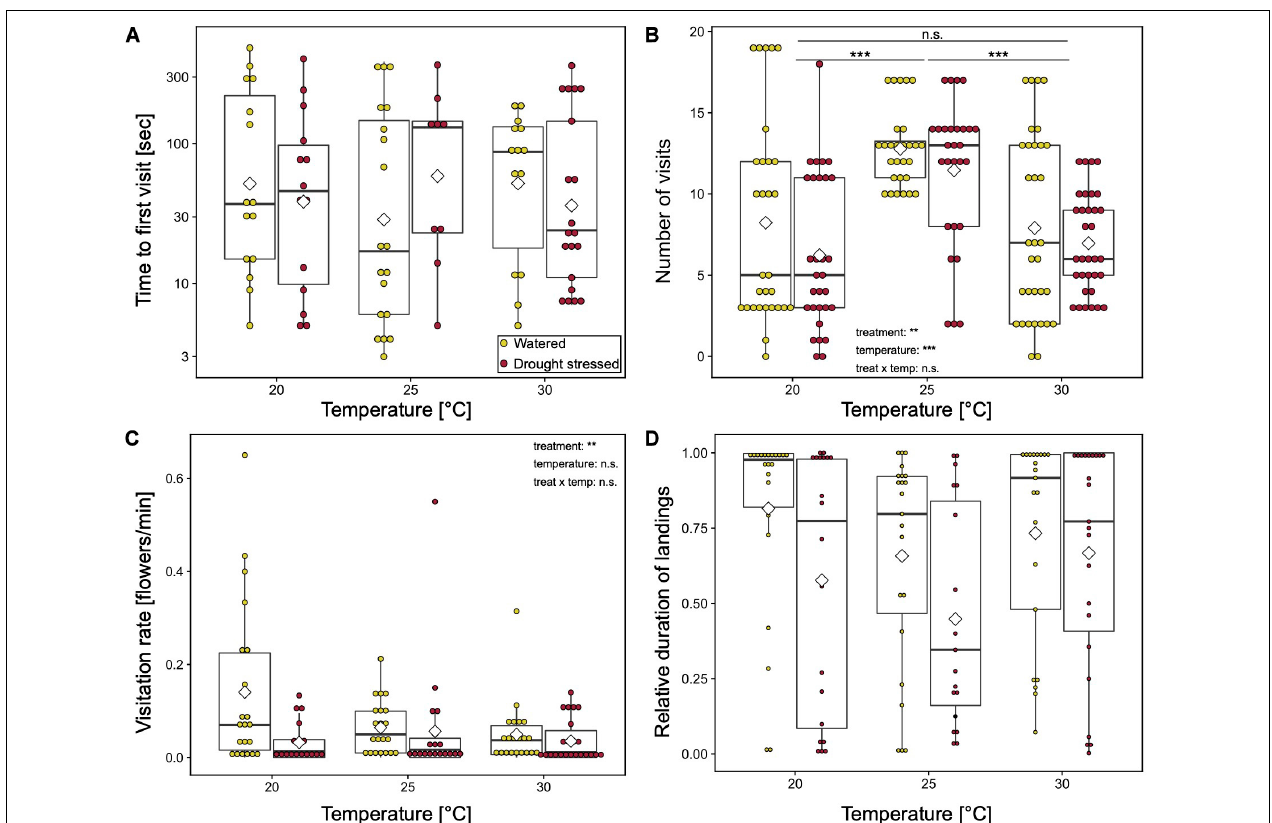
FIGURE 1 | Behavior of bumblebees at various temperatures with respect to watered and drought-stressed plants. (A) Time to first plant visit [sec] (approach or landing); (B) number of visits per plant (approaches plus landings); (C) flower visitation rate per landing [min]; and (D) relative duration of landings. Boxplots show median range, interquartile range, and minimum/maximum range. White diamonds show mean value. Means of each bumblebee were compared using general linear mixed effect models. *** p < 0.001; ** p < 0.01; and n.s.,